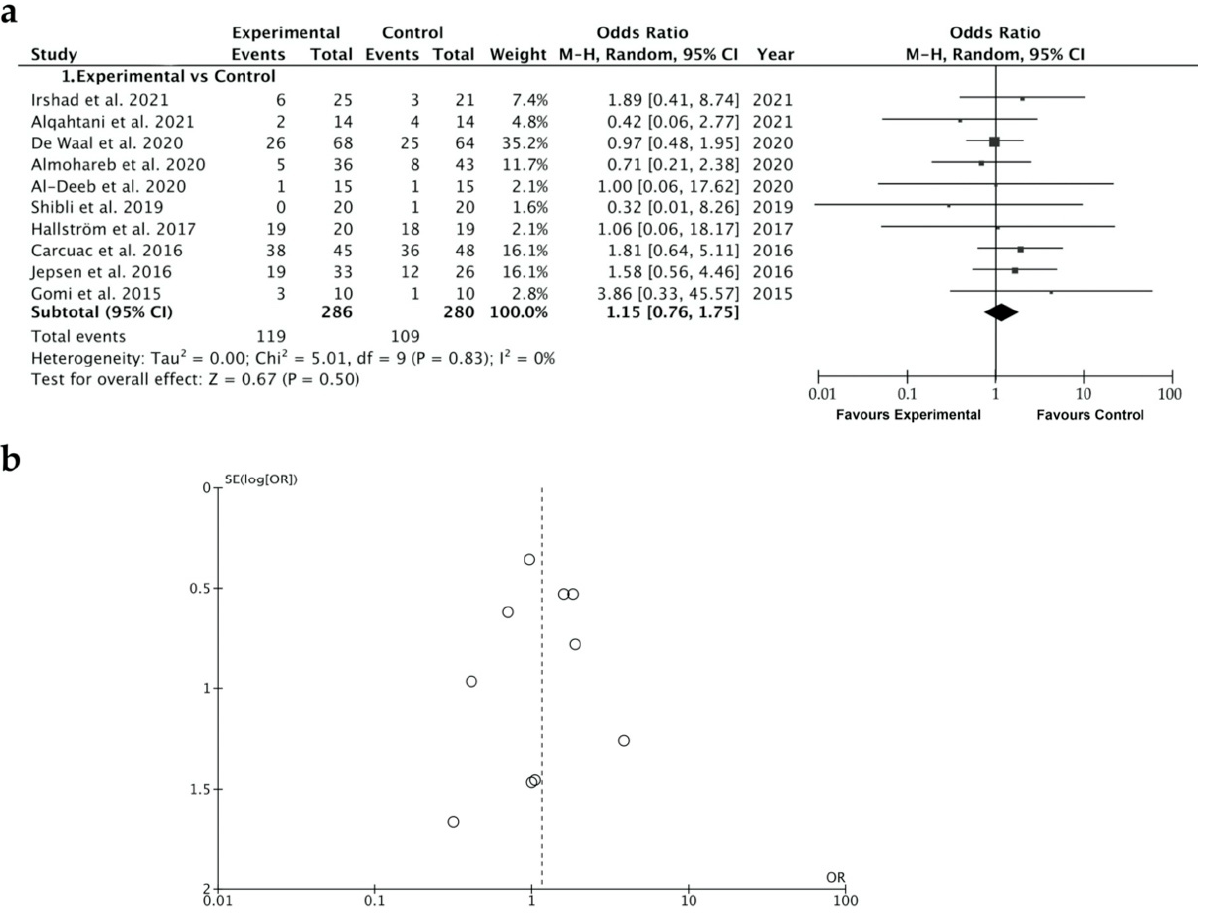
Figure 4. ( a ) Forest plot for no systemic antibiotic (control group) versus adjunct systemic antibiotic (test group) when comparing the bleeding on probing (BoP). ( b ) Funnel plot graph illustrating the publication bias and the systematic heterogeneity of the included studies. The standard error (SE) is represented in the vertical axis and the bleeding on probing (MD) in the horizontal axis [1,6,24,30,48,52,54–57].